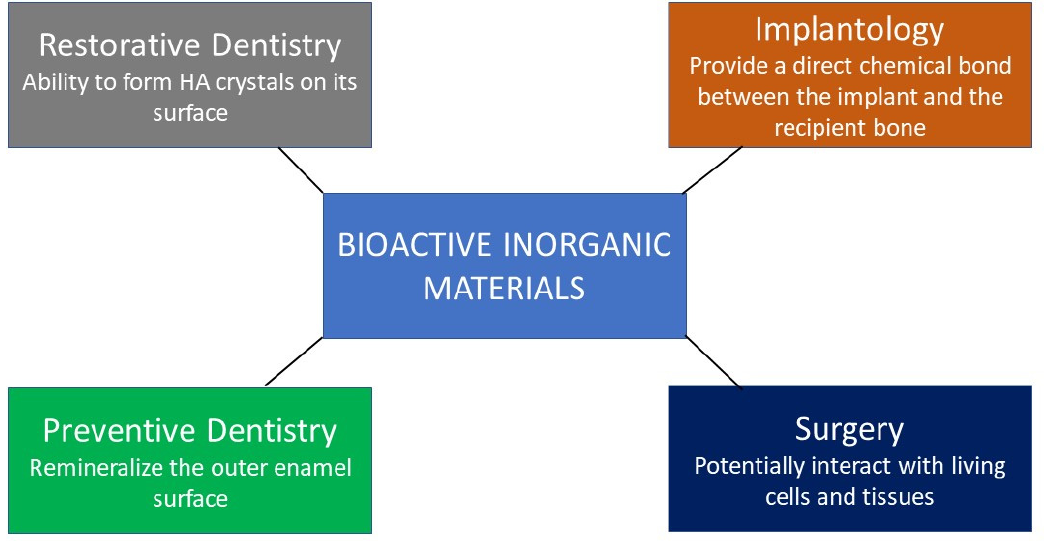
Figure 2. Perception of bioactive materials and their functions in different clinical applications.